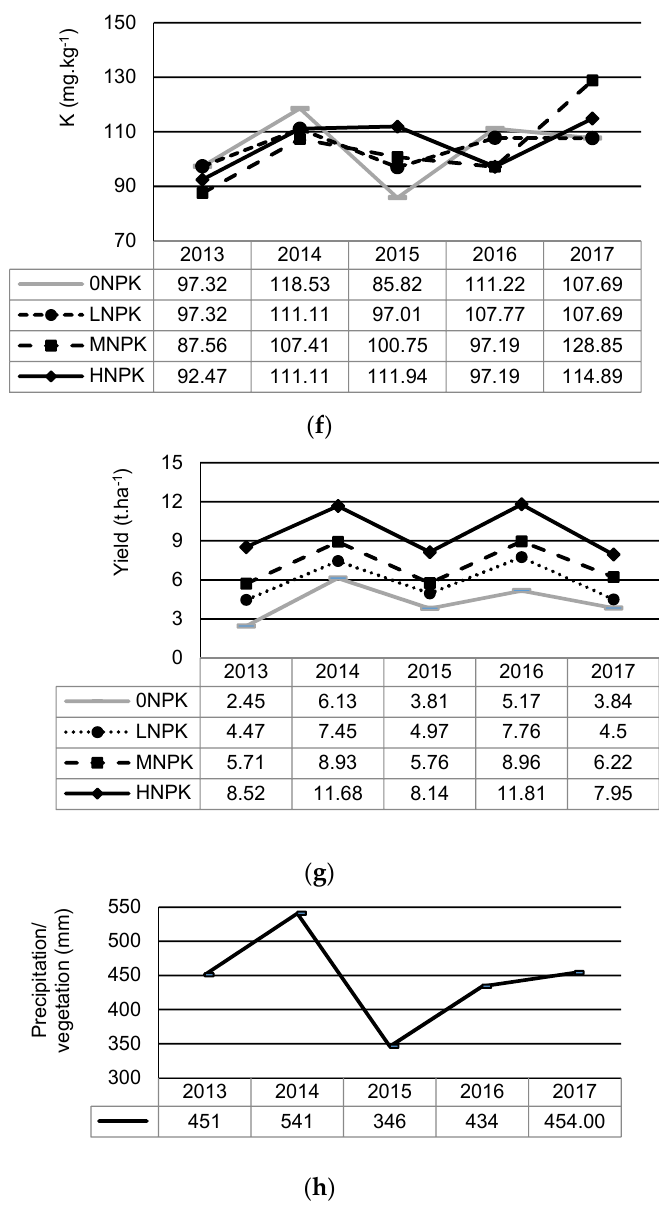
Figure 2. Changes in soil chemical properties, yields, and precipitation under the different NPK addition during 2013–2017: ( a ) soil pH; ( b ) soil organic carbon (SOC); ( c ) soil total nitrogen (STN); ( d ) C:N ratio (C:N); ( e ) plant-available phosphorus (P); ( f ) plant-available potassium (K); ( g ) plant yields; ( h ) precipitation during vegetation. Table 2. Mean and standard deviation values of soil chemical properties during 2013–2017. Treatment